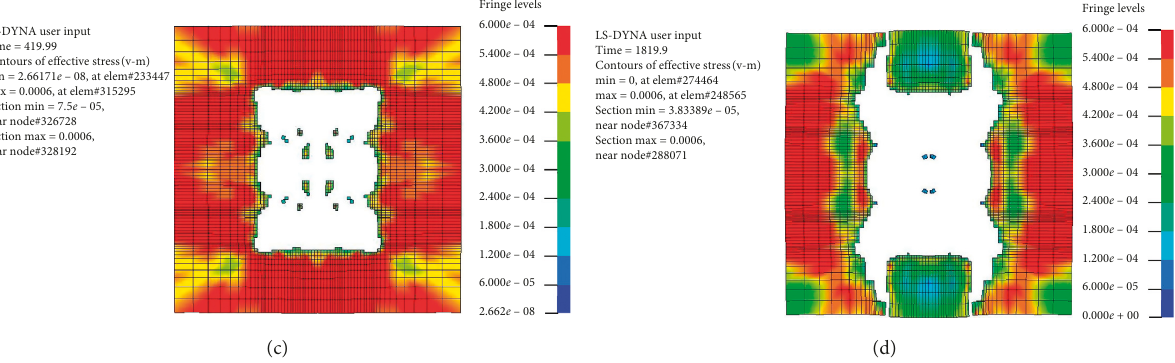
Figure 3: Spatiotemporal evolutionary cloud diagram of effective stress of two holes. (a) 240 μ s. (b) 280 μ s. (c) 420 μ s. (d) 1820 μ